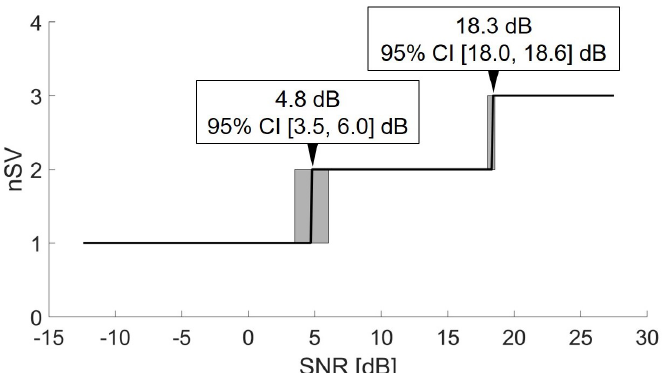
Figure 5. Calibration curve to establish the number of singular values to be used at each SNR level. The mean SNR and the 95% confidence interval are reported in the